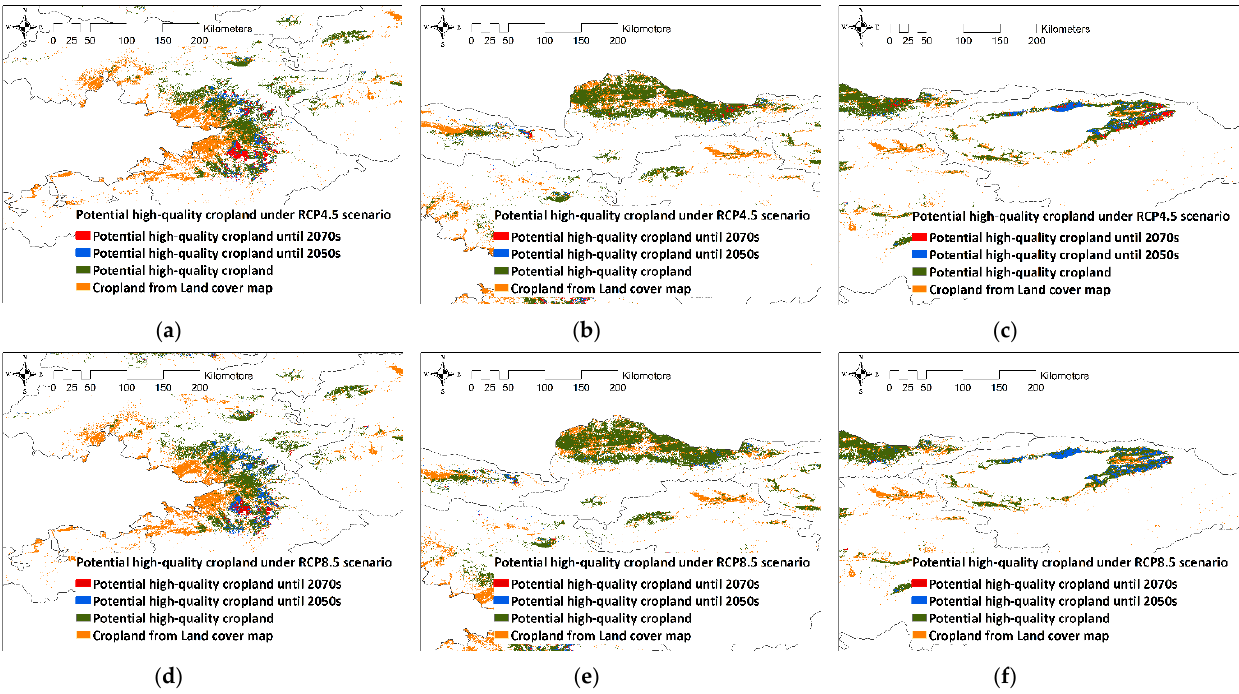
Figure 7. Spatial distribution of future potential high-quality croplands under different scenarios: ( a ) Fergana valley in RCP4.5; ( b ) Chu-Talas valley in RCP4.5; ( c ) Issyk-kul area in RCP4.5; ( d ) Fergana valley in RCP8.5; ( e ) Chu-Talas valley in RCP8.5; and ( f ) Issyk-kul area in RCP8.5.